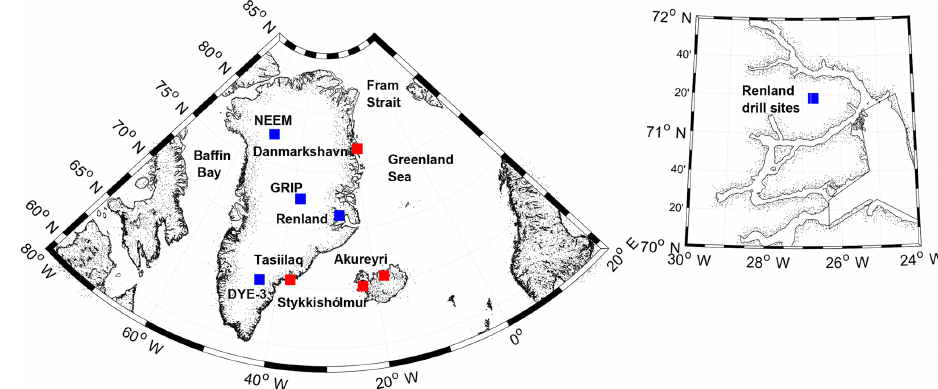
Figure 1. Locations of ice core drill sites (blue squares) and the instrumental temperature records (red squares). Table 1. The subset of the three ice cores used in this study: processing information, analysis and coordinates. Cores Coordinates Time span Depth span Meas. Resolution Analysis RECAP 71 ◦ 18 (cid:48) 18 (cid:48)(cid:48) N, 26 ◦ 43 (cid:48) 24 (cid:48)(cid:48) W; 2315ma.s.l. 1801–2014 111 . 7m δ 18 O, δ D 0 . 5cm CFA-L2130 1988 M 71 ◦ 18 (cid:48) 17 (cid:48)(cid:48) N, 26 ◦ 43 (cid:48) 24 (cid:48)(cid:48) W; 2340ma.s.l. 1801–1987 92 . 5m δ 18 O 5 . 0cm IRMS 1988 S 71 ◦ 18 (cid:48) 17 (cid:48)(cid:48) N, 26 ◦ 43 (cid:48) 24 (cid:48)(cid:48) W; 2340ma.s.l. 1801–1987 91 . 6m δ 18 O 5 . 0cm